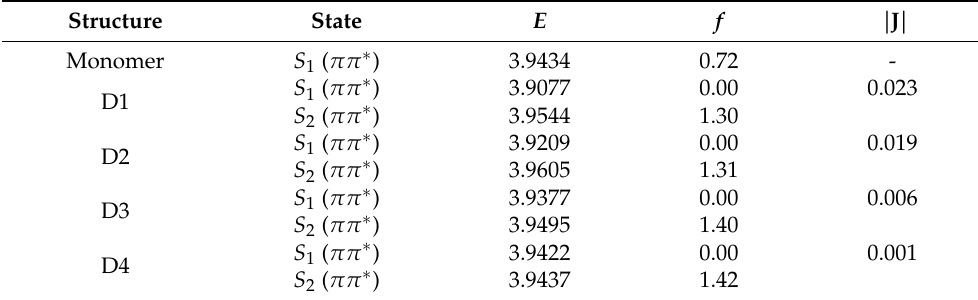
Table 3. Excitation energies ( E in eV), oscillator strengths ( f ) of monomer and relevant dimers and exciton coupling values ( J in eV) between units in dimers isolated from TPF crystal. Structure